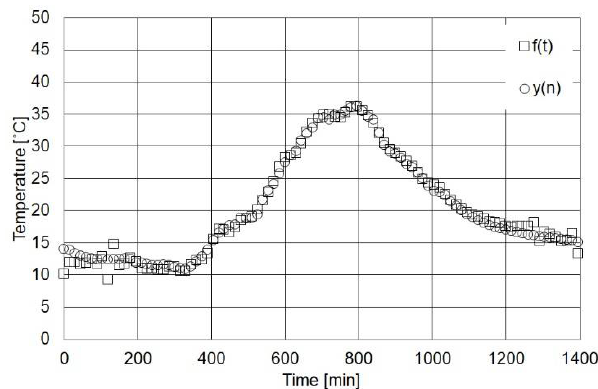
Figure 8. Measured temperature data points versus the continuous function provided by the signal reconstruction algorithm for a non-exposed wall in sunny spring conditions (NESS).